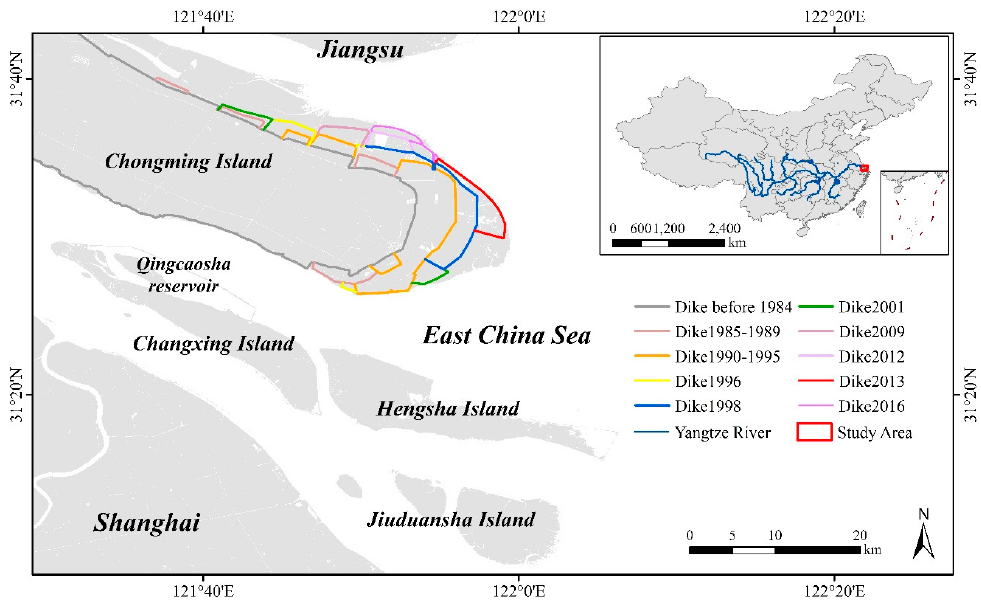
Figure 1. Location of mouth of Yangtze River and dikes with construction years on eastern Chongming Island (CMI).